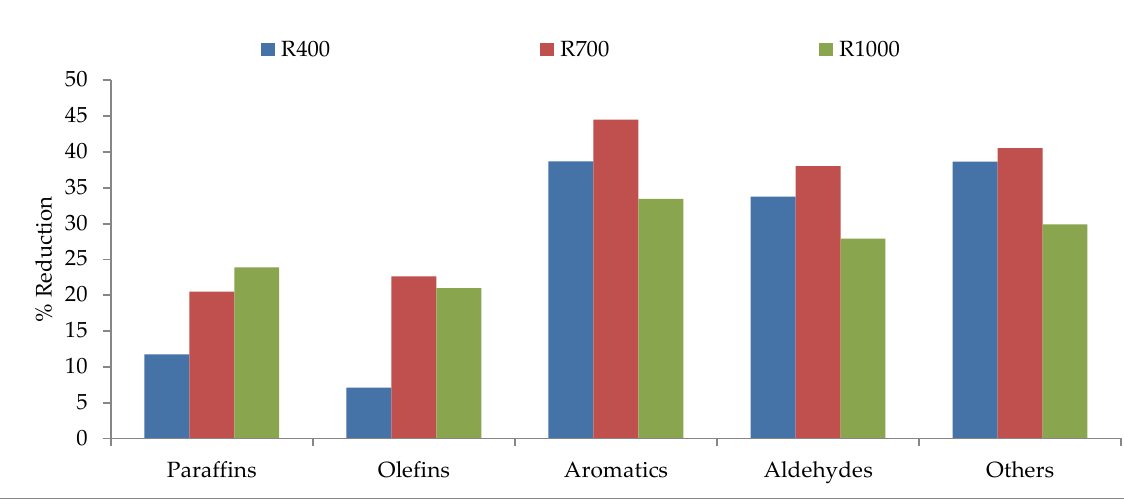
Figure 13. Reduction obtained for the different families of compounds in the gases collected in the study of the stirring rate (rpm) at the first step of the synthesis with fixed conditions of time, 24 h, and temperature (40°).